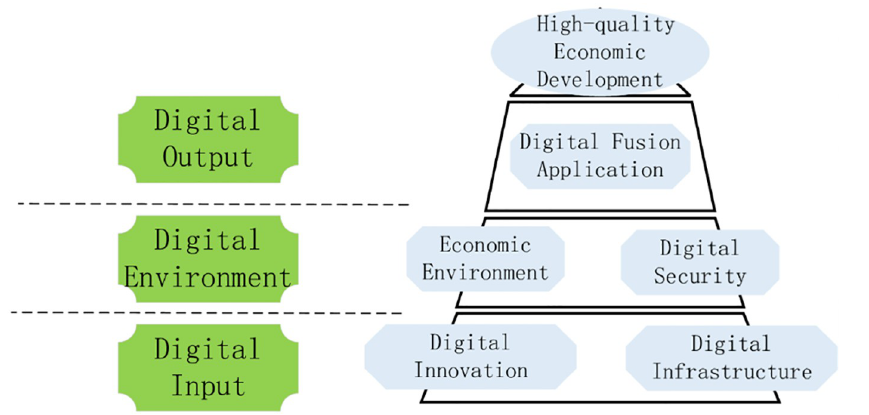
Fig 3. Logical framework of digital economy index